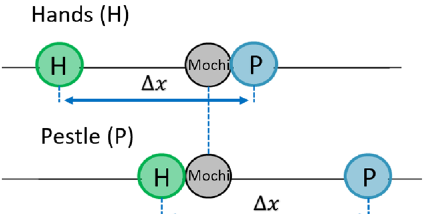
Fig. 3 Relative Distance between the Hands and the Pestle during task. Top: Pestling phase. Bottom: Kneading